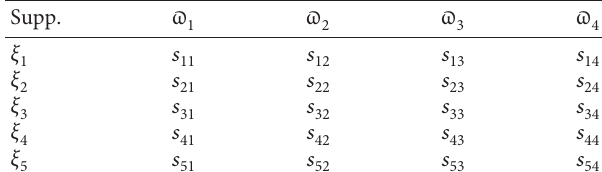
Table 6: The ratings of the alternatives for ϖ Supp.